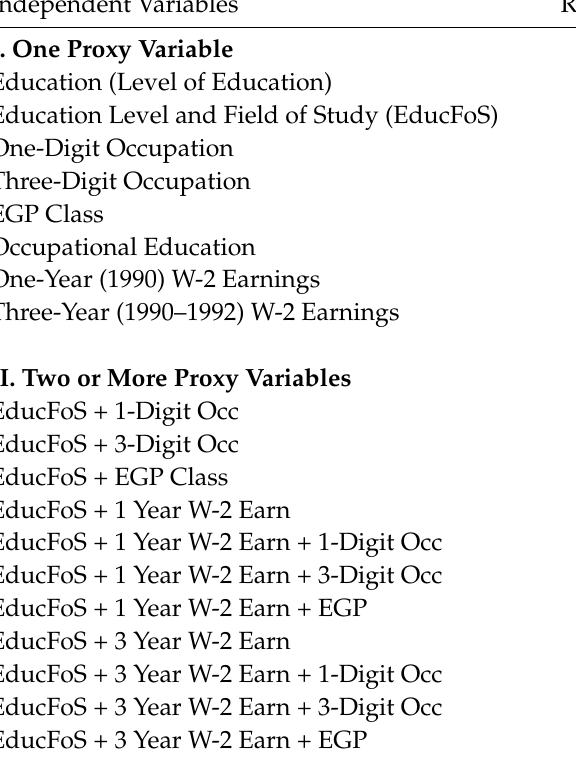
Table 3: Results for OLS models of log–long-term earnings, women. Independent